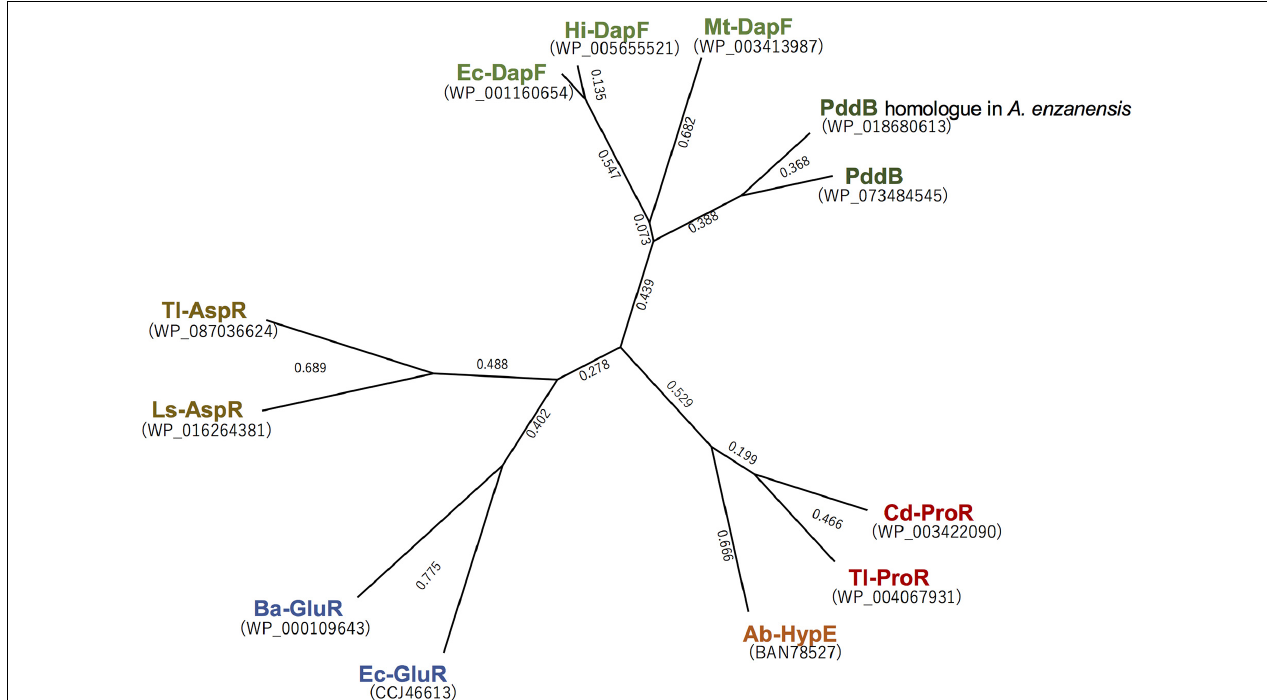
FIGURE 6 | Phylogenetic tree analysis of the selected PLP-independent racemases/epimerases. The tree was generated in Genetyx software with the Unweighted Pair Group Method using the arithmetic Average (UPGMA) method. Ba-GluR, glutamate racemase from Bacillus anthracis ; Ec-GluR, glutamate racemase from Escherichia coli ; Ls-AspR, aspartate racemase from Lactobacillus sakei ; Tl-AspR, aspartate racemase from Thermococcus litoralis ; Hi-DapF, DapF from Haemophilus influenzae ; Ec-DapF, DapF from E. coli ; Cd-ProR, proline racemase from Clostridioides difficile ; Tl-ProR, proline racemase from T. litoralis ; Ab-HypE, L-hydroxyproline 2-epimerase from Azospirillum brasilense .